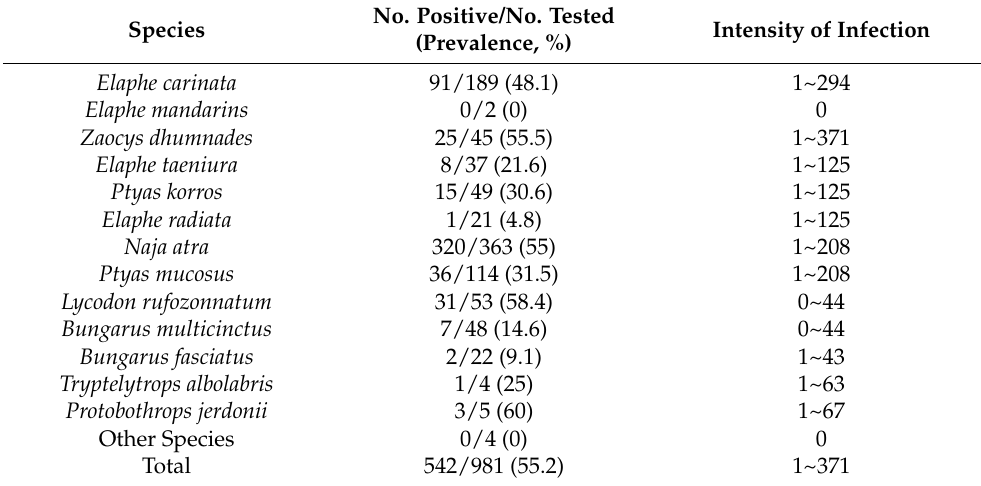
Table 3. Infection investigation of different species of